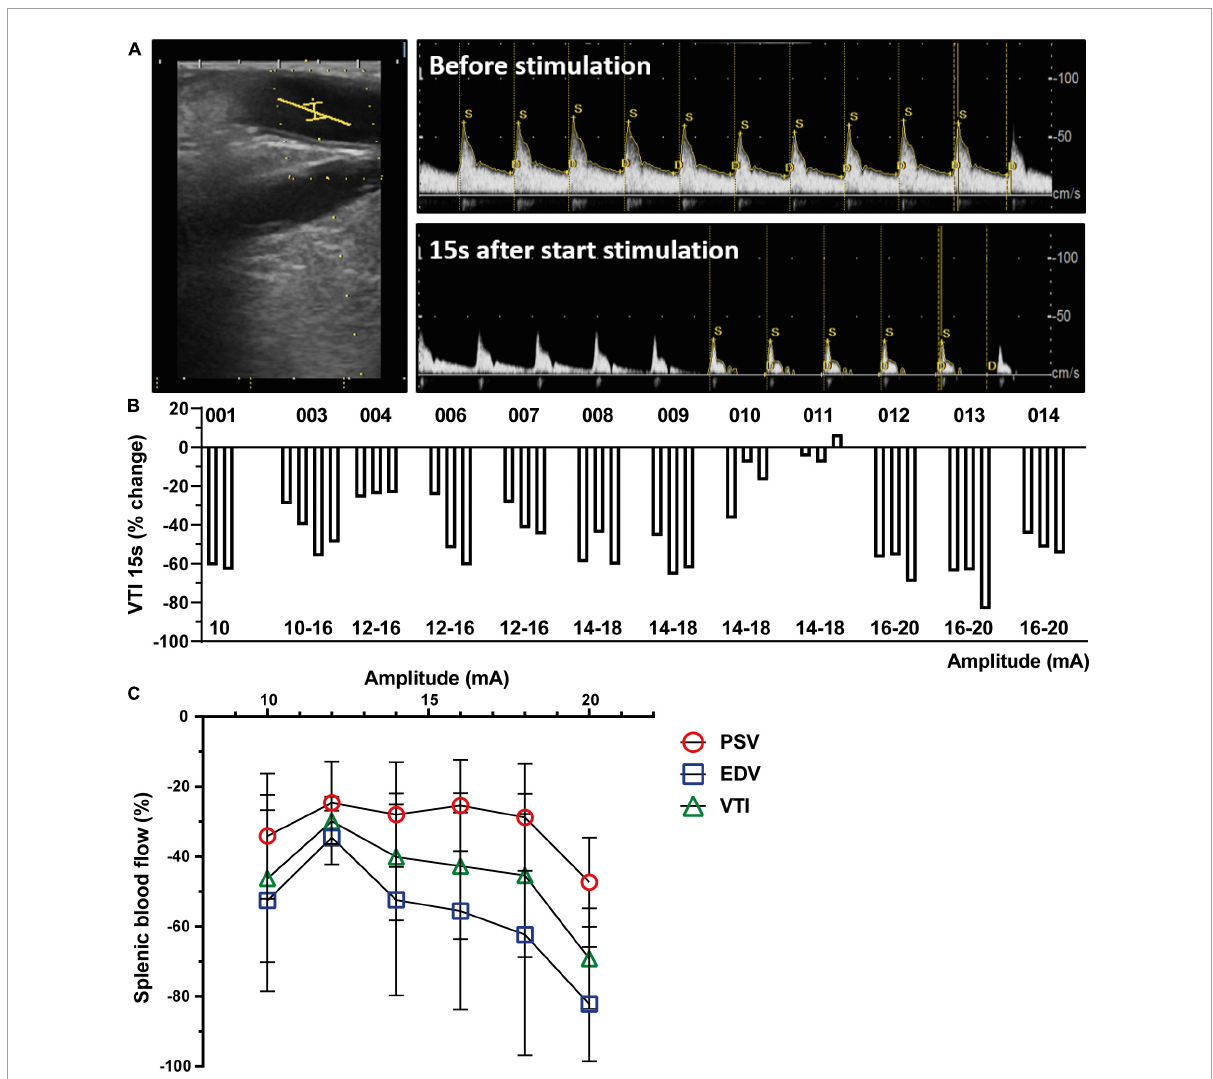
FIGURE2 Splenic nerve bundle stimulation caused a reproducible splenic arterial blood flow change. (A) Representative ultrasound image of the SpA (left). The ultrasound probe was placed parallel to the splenic artery. A center point (yellow lines) in the artery was chosen to measure Doppler flow velocity profiles before (upper) and after start of stimulation (lower). (B) Change in blood flow (VTI) presented as percentage change compared to baseline 15 s after start of SpNS as presented per patient for each stimulation. The amplitudes of the stimulation are listed below. (C) Effect of increasing stimulation amplitudes on decrease in PSV, EDV, and VTI, averaged over all patients, compared to baseline 15 s after start of SpNS. SpA, splenic artery; SpNS, splenic nerve bundle stimulation; VTI, Velocity Time Integral; PSV, Peak Systolic Velocity; EDV, End Diastolic